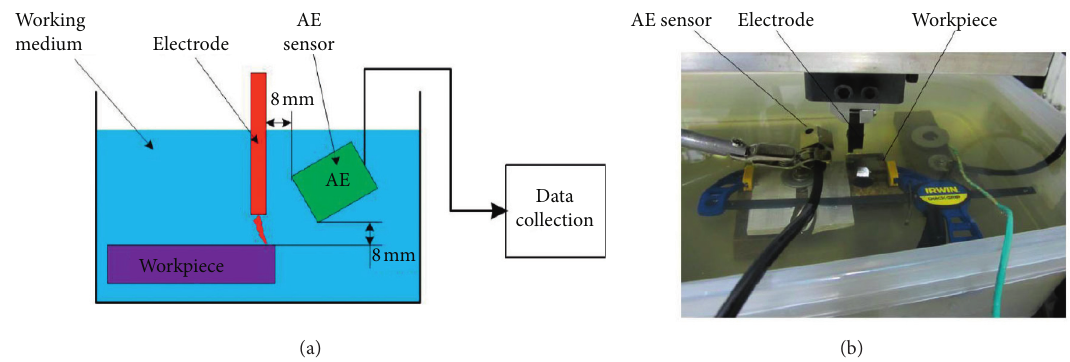
Figure 1: The placement of the experiment setup: (a) schematic diagram and (b) experiment setup.